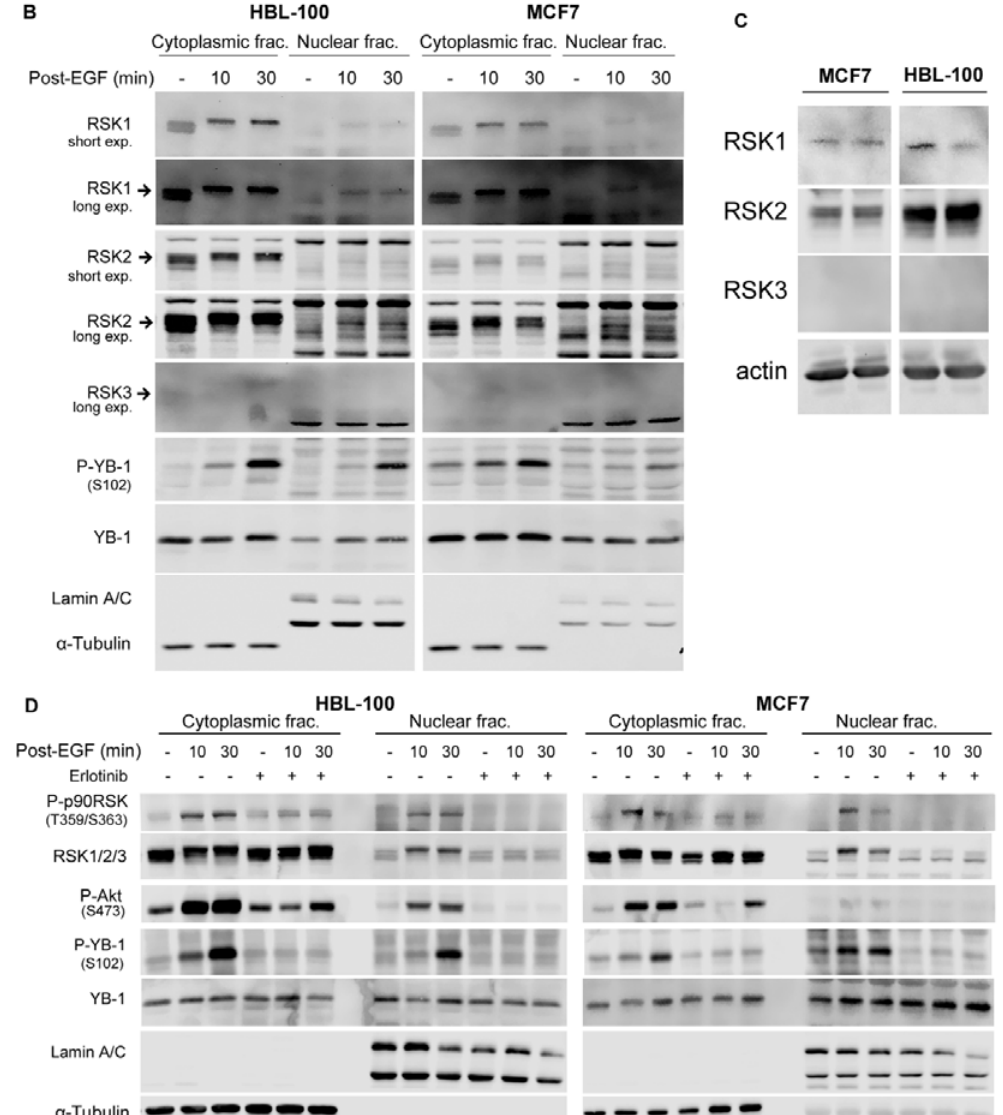
Figure 2. Phosphorylation of nuclear YB-1 after stimulation with epidermal growth factor (EGF) is associated with nuclear accumulation of RSK1 and RSK2 but not YB-1. ( A , B ) KRASwt HBL-100, and MCF7 cells were treated with EGF (100 ng/mL). Cytoplasmic and nuclear fractions were isolated at the indicated time points after stimulation. ( C ) Total protein samples (60 µ g) were extracted under untreated control condition. ( D ) Cells were treated with erlotinib (10 µ M, 2 h) followed by EGF treatment. Cytoplasmic and nuclear protein fractions were isolated at the 10 min and 30 min time-points after EGF treatment. P-RSK, RSK1/2/3, RSK1, RSK2, RSK3, P-YB-1, YB-1 and P-Akt were detected by Western botting. α -Tubulin and lamin A/C were used as cytoplasmic and nuclear markers, respectively.